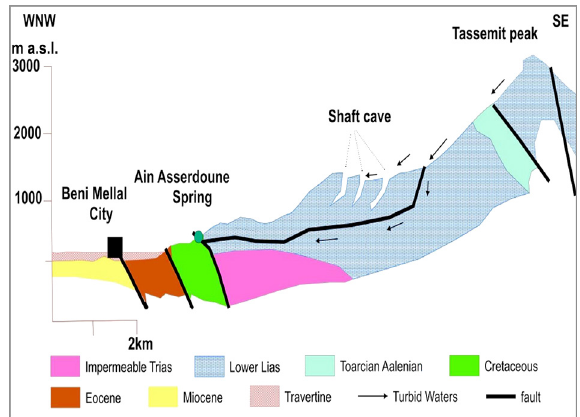
Fig. 5. Hydrogeological section showing the emergence conditions of Ain Asserdoune, Beni